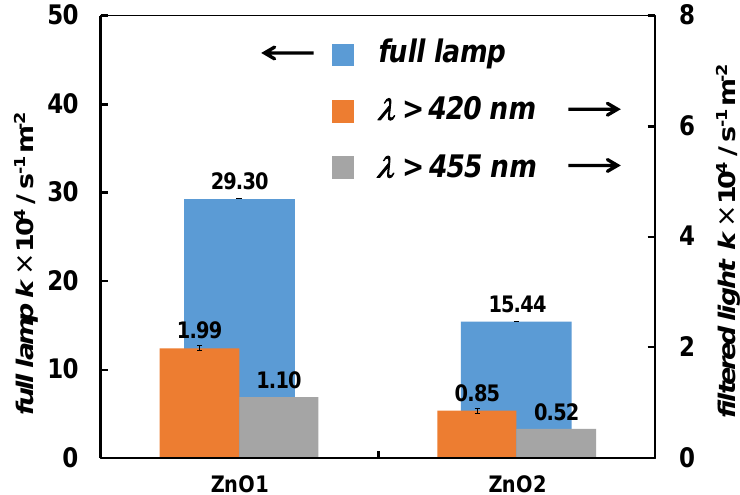
Figure 6. Surface-normalized first order rate constants of RhB photocatalytic degradation in the presence of 0.1 g L −1 of ZnO photocatalysts under different irradiation conditions. Specific surface area values of ZnO1 and ZnO2 are reported in Table 1.